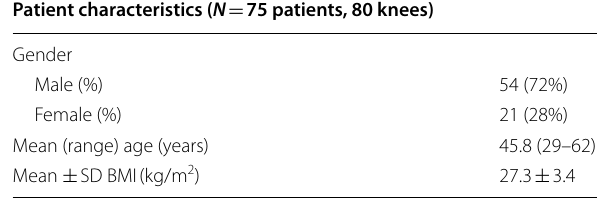
Patients’ demographic data before surgery. The study included, at baseline, 75 patients for a total of 80 knees. Gender is reported in absolute values